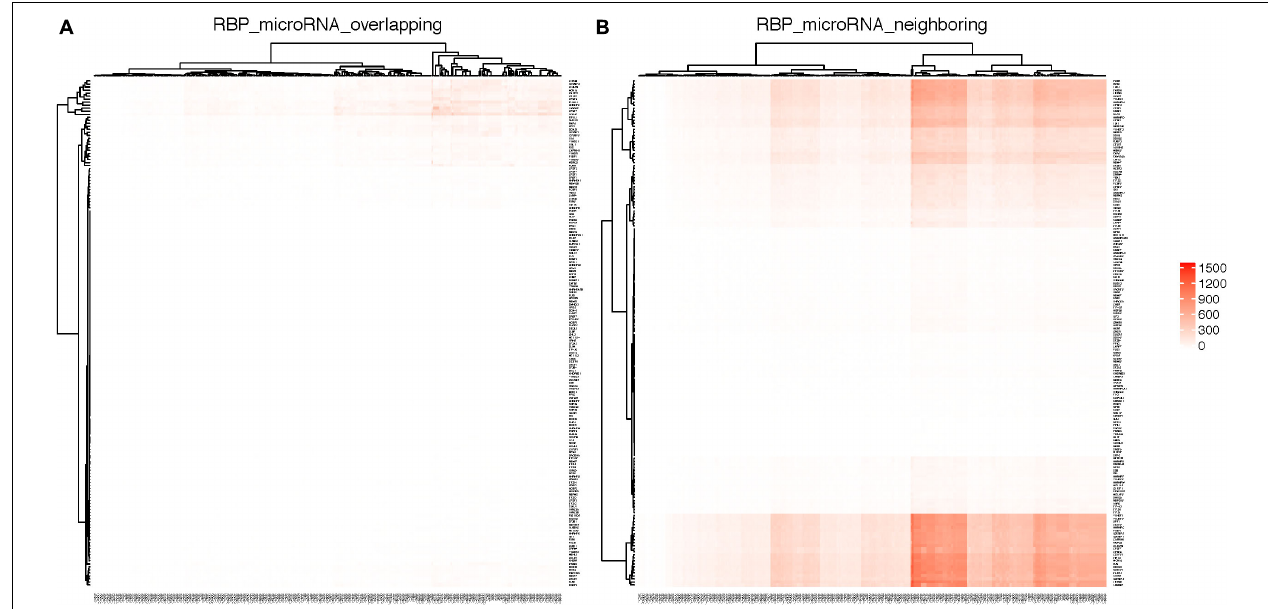
FIGURE 6 | RBPs and microRNAs that have overlapping or neighboring binding sites. RBPs are listed on the Y -axis and microRNAs are listed on the X -axis. Color in each cell represents the number of genes on which the RBP and the microRNA have overlapping (A) or neighboring (B) binding sites. As the result of clustering, the order of RBPs or microRNAs are different between left and right panels. TABLE 4 | List of RBP-microRNA pairs that have the highest number of overlapping and neighboring binding sites. miRNA Number of Number of target genes overlapping with overlapping binding binding sites